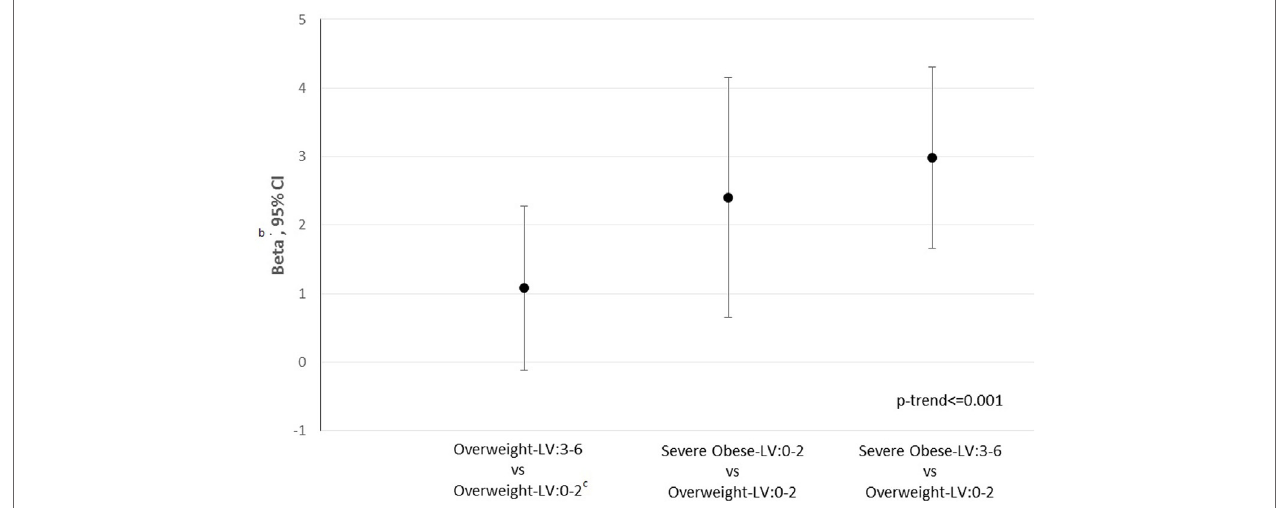
FigUre 1 | 10-Year cardiovascular disease (CVD) a risk according to CYP27A1 body mass index-low hydroxylation (LH) category. a 10-Year CVD score calculated using Framingham equation. b We reported as effect the coefficient beta and 95% confidence intervals from adjusted linear regression models [adjusted for sex, age, smoking, status (yes, no and ex-smokers)], expressing the change in arithmetic mean of outcome switching from one category to the reference one (overweight- LH: 0–2). c Reference: overweight-LH: 0–2.